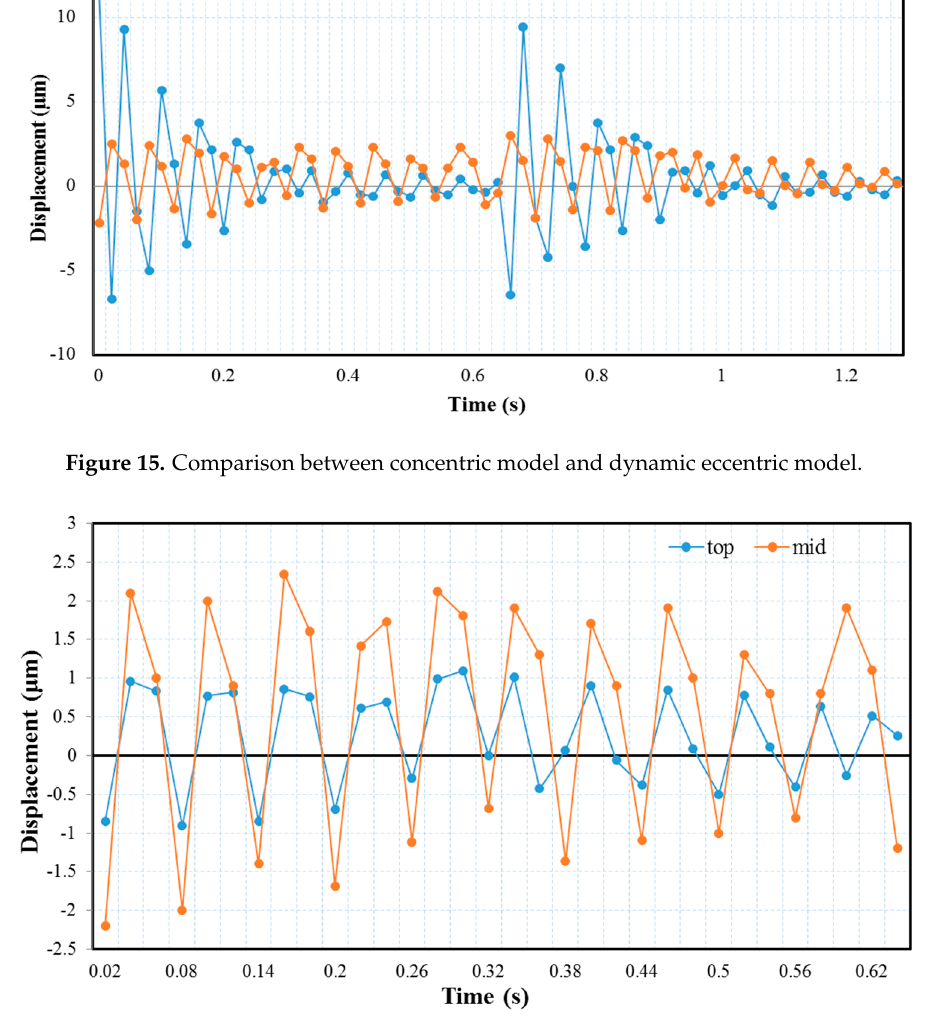
Figure 16. The transient analysis results of concentric model.